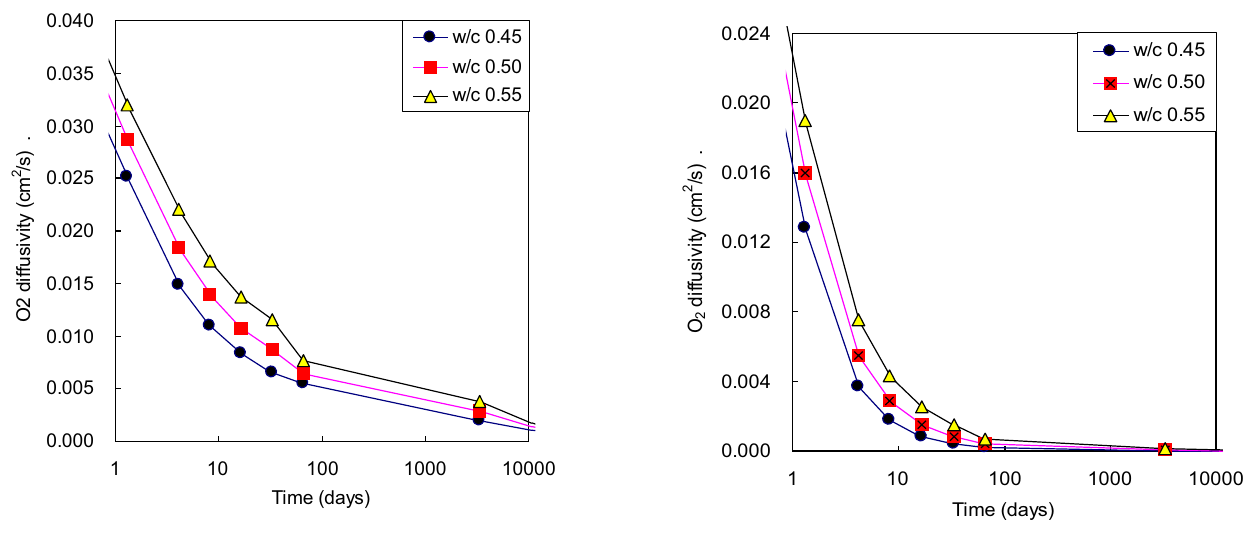
Fig. 6 Effective oxygen diffusivity of noncarbonated